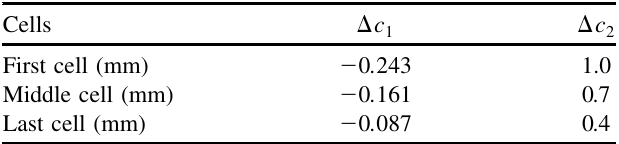
TABLE II. Size change in each cell for detuning method to get 3 GHz mode separation. (cid:1) c 1 indicates radius change of main cavity. (cid:1) c 2 indicates radius change of inner radial line.